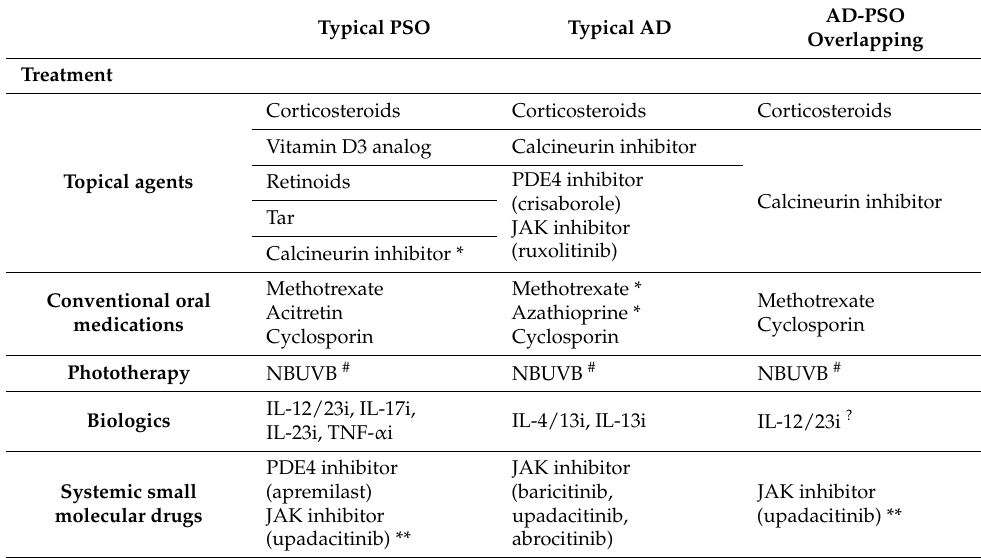
Table 2. Reasonable choices for overlapping